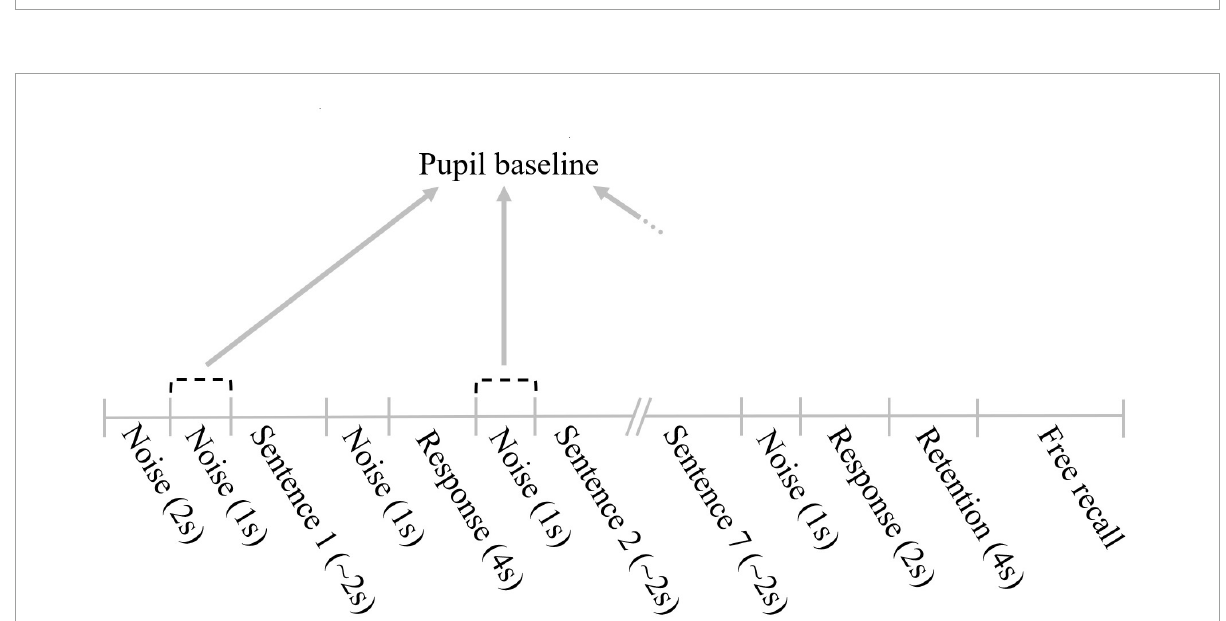
FIGURE2 Illustration of the structure of a SWIR test block and the method of calculating the pupil baseline. The duration of the different phases of the block are indicated in seconds